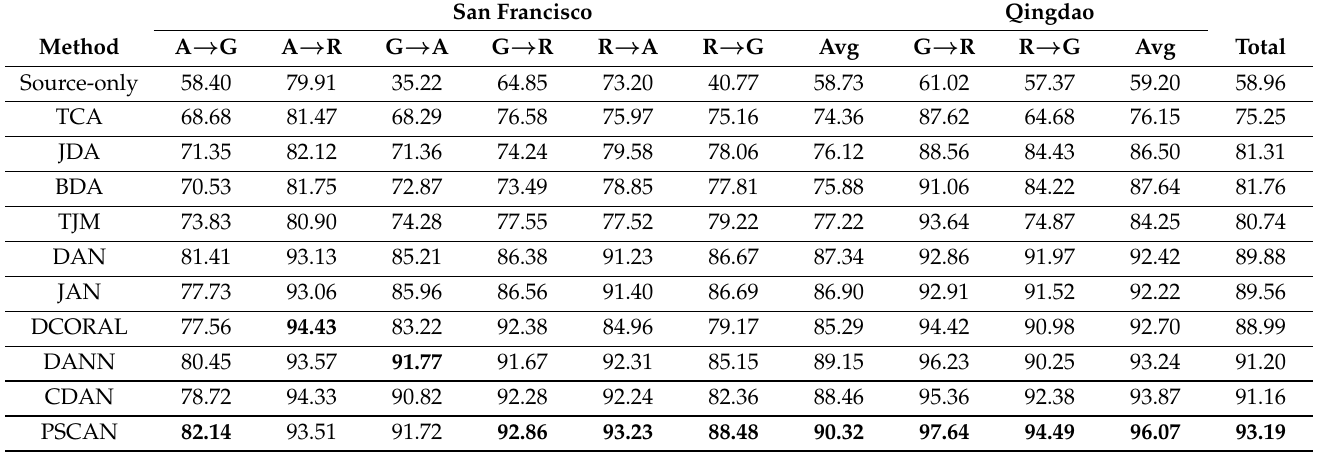
Table 1. Comparison of the overall accuracy (%) on all transfer tasks. The A, G, and R in the first column represent the ALOS-2, GF-3, and RS-2 datasets, respectively, and the Avg means average of the performance of each task. With A → G taken as an example, the ALOS-2 is the source domain and GF-3 is the target domain. The best results are highlighted in